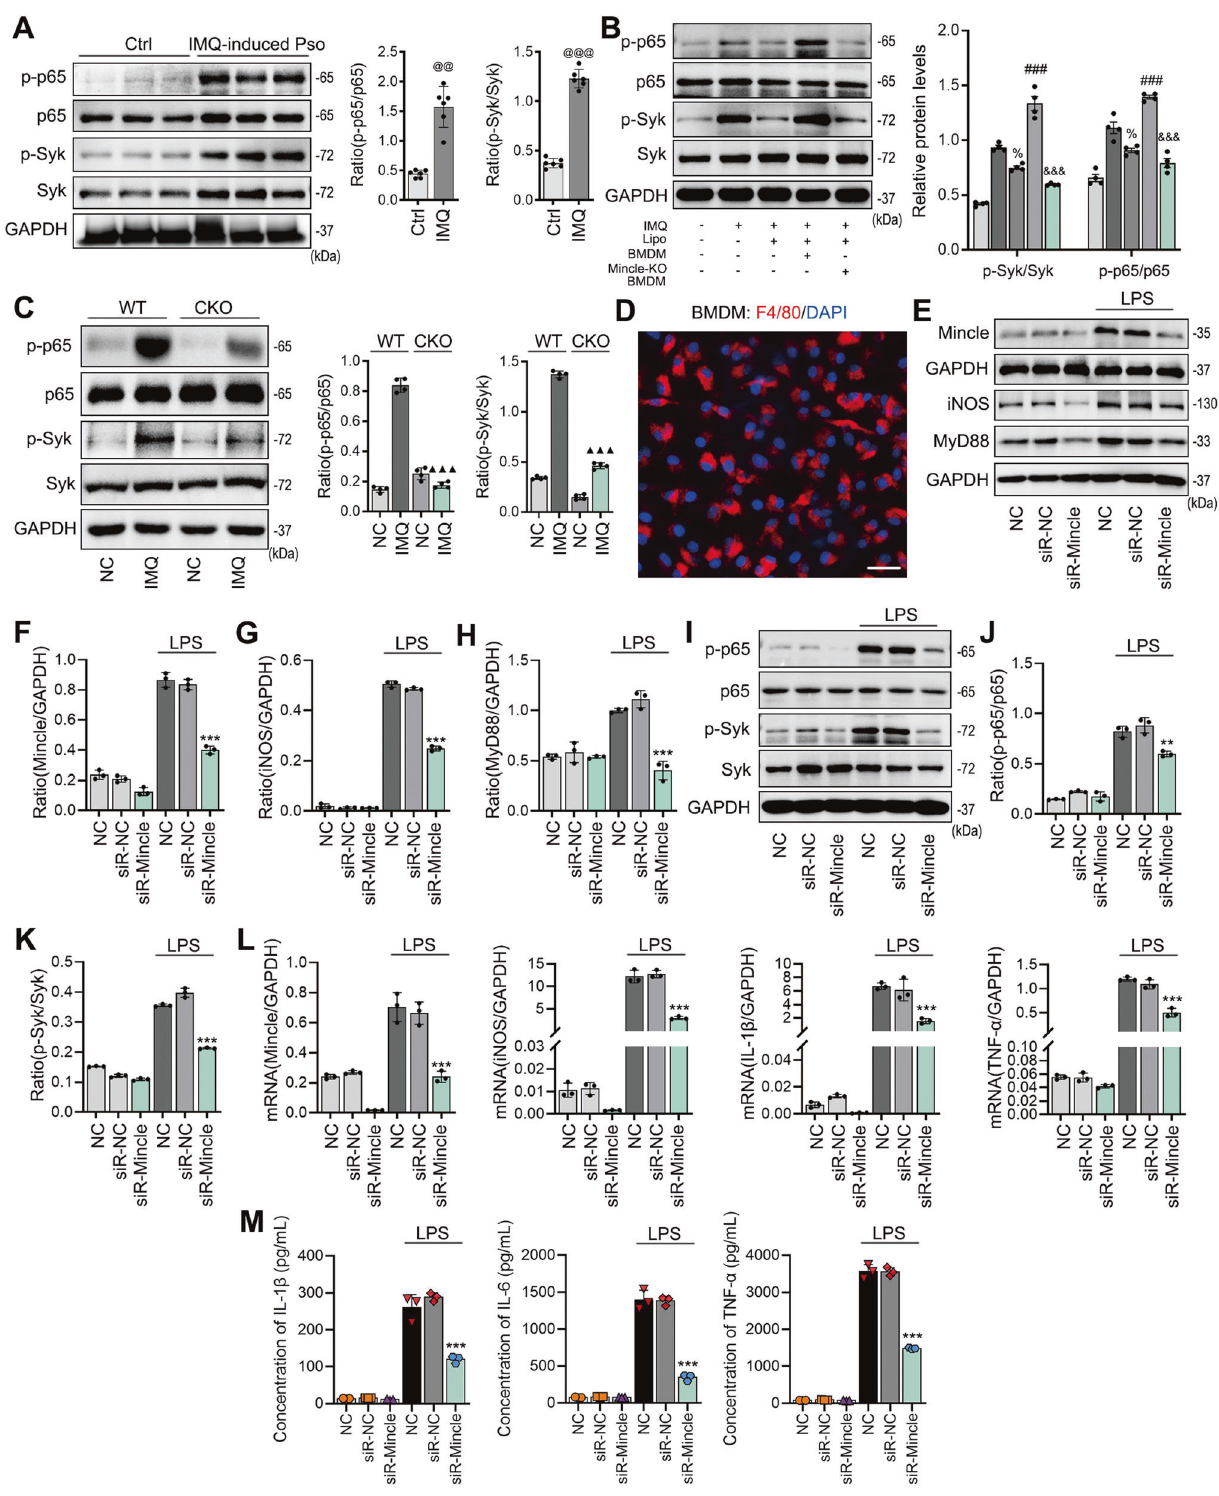
Fig. 5 Mincle mediates M1 macrophage activation via the Syk-NF- κ B mechanism in vivo and in vitro. A Western blot detected the protein levels of p-p65, p65, p-Syk and Syk in skin of each group, n = 6 in each group. B Western blot results showed the protein levels of p-p65, p65, p-Syk and Syk in skin of each group, n = 4 in each group. C Western blot results showed the protein levels of p-p65, p65, p-Syk and Syk in skin of WT and Mincle-KO mice, n = 4 in each group. D Identi fi cation of the differentiation of mouse bone marrow-derived macrophages (BMDM) by immuno fl uorescence. E – H Western blot results of Mincle, iNOS and MyD88 protein levels in BMDM cells, n = 3 in each group. I – K Western blot results of p-p65, p65, p-Syk and Syk protein levels in BMDM cells, n = 3 in each group. L The results of Real-time PCR showed that expression levels of Mincle, iNOS, IL-1 β and TNF- α in BMDM cells, n = 3 in each group. M ELISA analyzed the secretion of IL-1 β , IL-6 and TNF- α in the supernatant of BMDM cells, n = 3 in each group. @@ P < 0.01, @@@ P < 0.001 vs. Ctrl mice; % P < 0.05 vs. IMQ mice; ### P < 0.001 vs. IMQ + Lipo group; &&& P < 0.001 vs. IMQ + Lipo + BMDM group; ▲▲▲ P < 0.001 vs. WT-IMQ mice; ** P < 0.01, *** P < 0.001 vs. LPS group. Cell Death Discovery (2023)